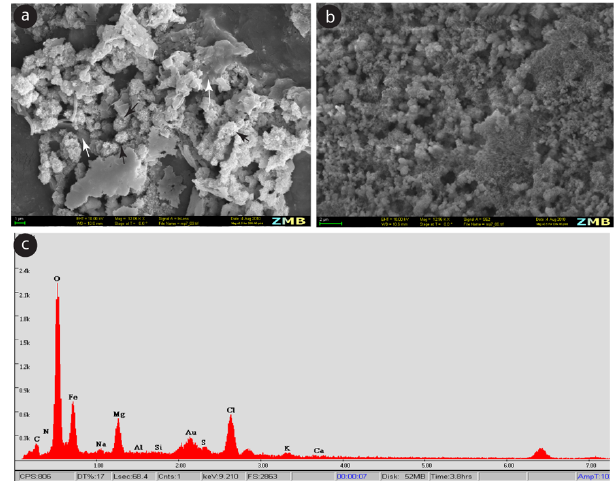
Fig. 15. Secondary electron images of the ferromanganese crusts: (a) the biofilm inoculated in the iron-rich medium. Note that 1µm- wide rosettes showing a crenulated surface (black arrows) are closely related to extracellular polymeric substances (white arrows). (b) Detail of amorphous iron oxides in the sterile iron-rich medium appearing as nanoglobules. (c) Elemental analyses of the rosettes (a) indicating a strong contribution of magnesium in the iron ox-